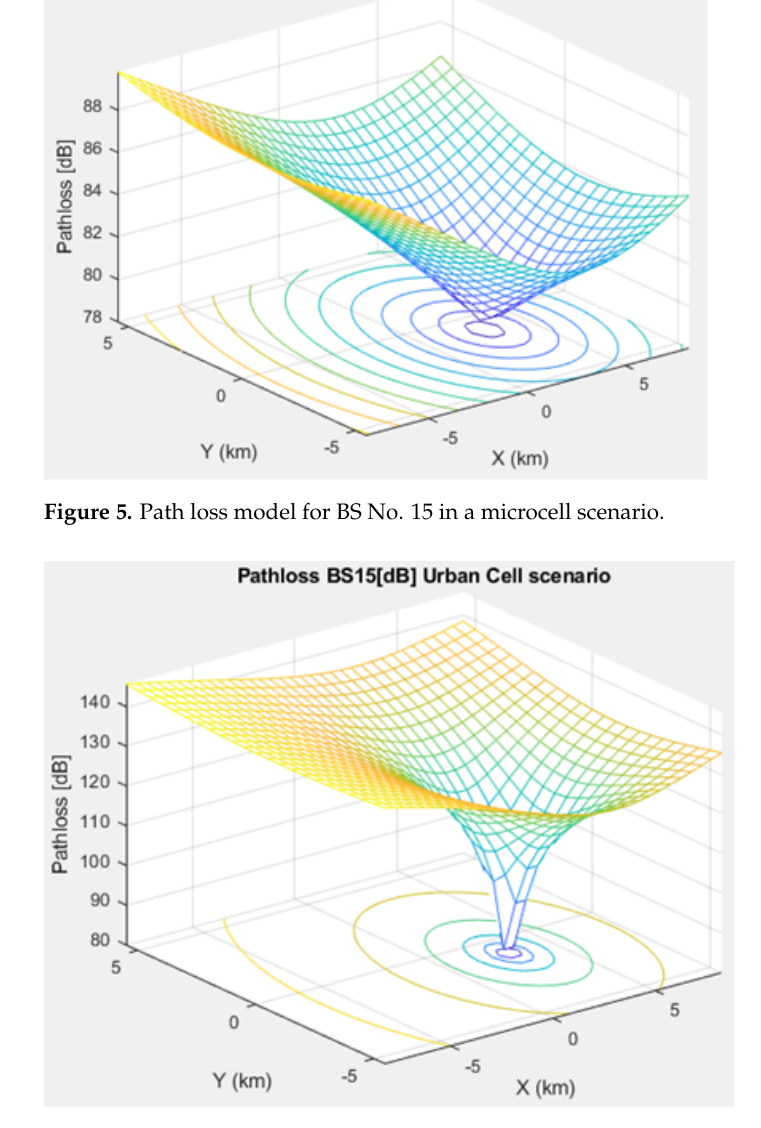
Figure 6. Path loss model for BS No. 15 in an urban macrocell